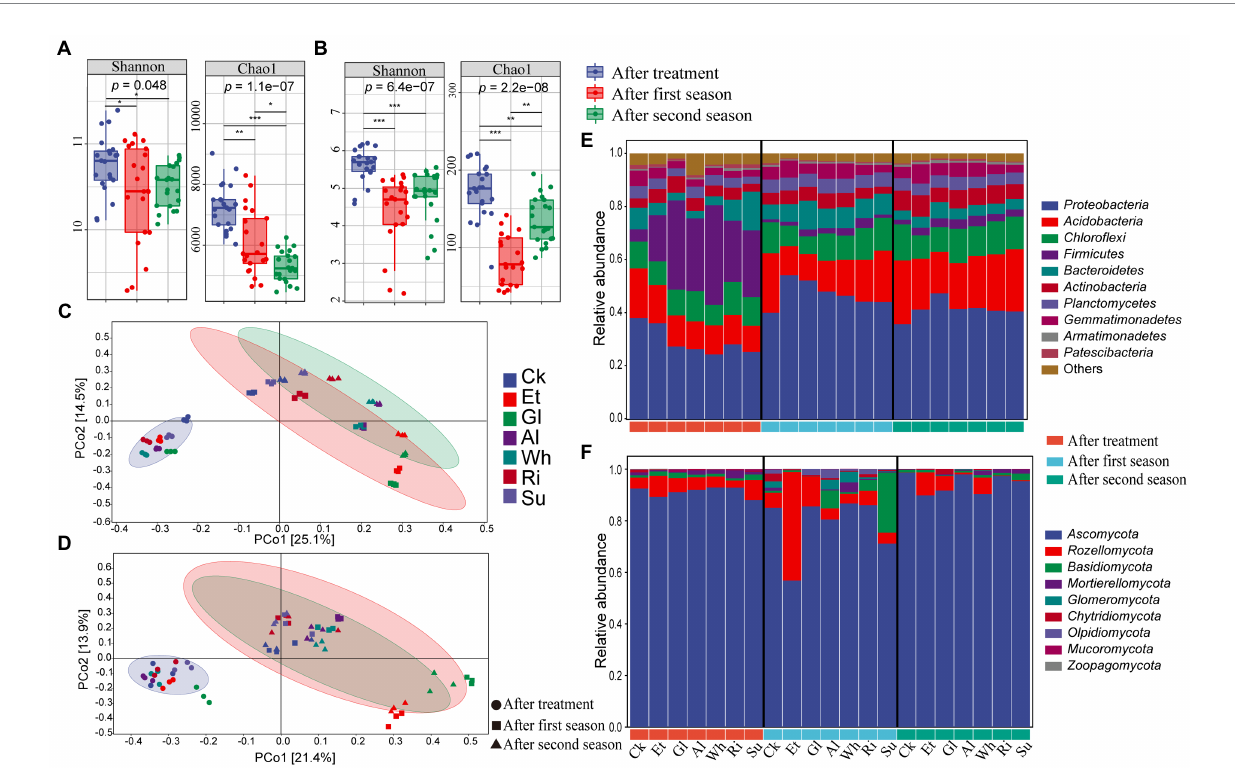
FIGURE 2 (A,B) Alpha diversity indices of bacterial and fungal communities in different soils collected after RSD treatment and two planting seasons. The significance of different groups was determined by the p values (ANOVA, Tukey’s HSD). * p < 0.05; ** p < 0.01; *** p < 0.001. (C,D) Principal coordinates analyzes (PCoA) were conducted based on soil bacterial and fungal ASVs using Bray-Curtis distance. (E,F) Soil bacterial and fungal community compositions at phylum level in different soils collected after RSD treatment and two planting seasons. Treatment abbreviations are defined in Table